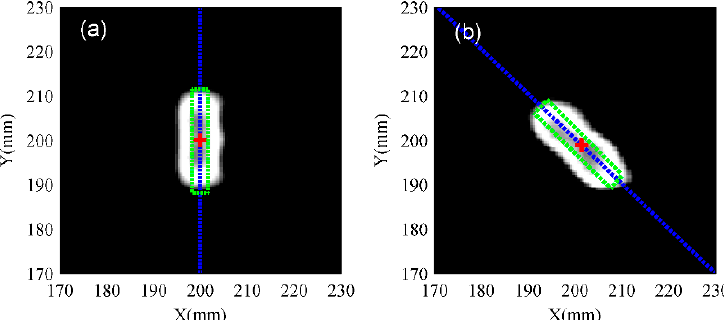
Figure 15. The direction identification of an inclined rectangular groove based on the numerical result. ( a ) 90°; ( b ) 135°. The red plus (+) indicates the centroid location. The blue dashed line is the spindle. The green dash line is the boundary of the inclined rectangular groove. The background image is a grayscale image which is processed by a threshold at the level of − 3 dB. Table 6. The depth and angle evaluations of Case 10 and Case 11.